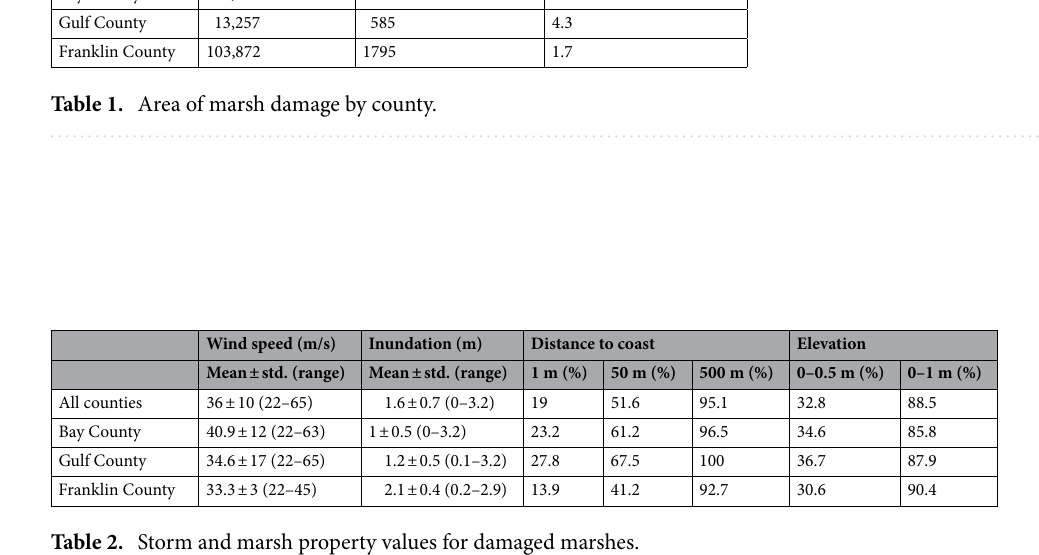
Table 2. Storm and marsh property values for damaged